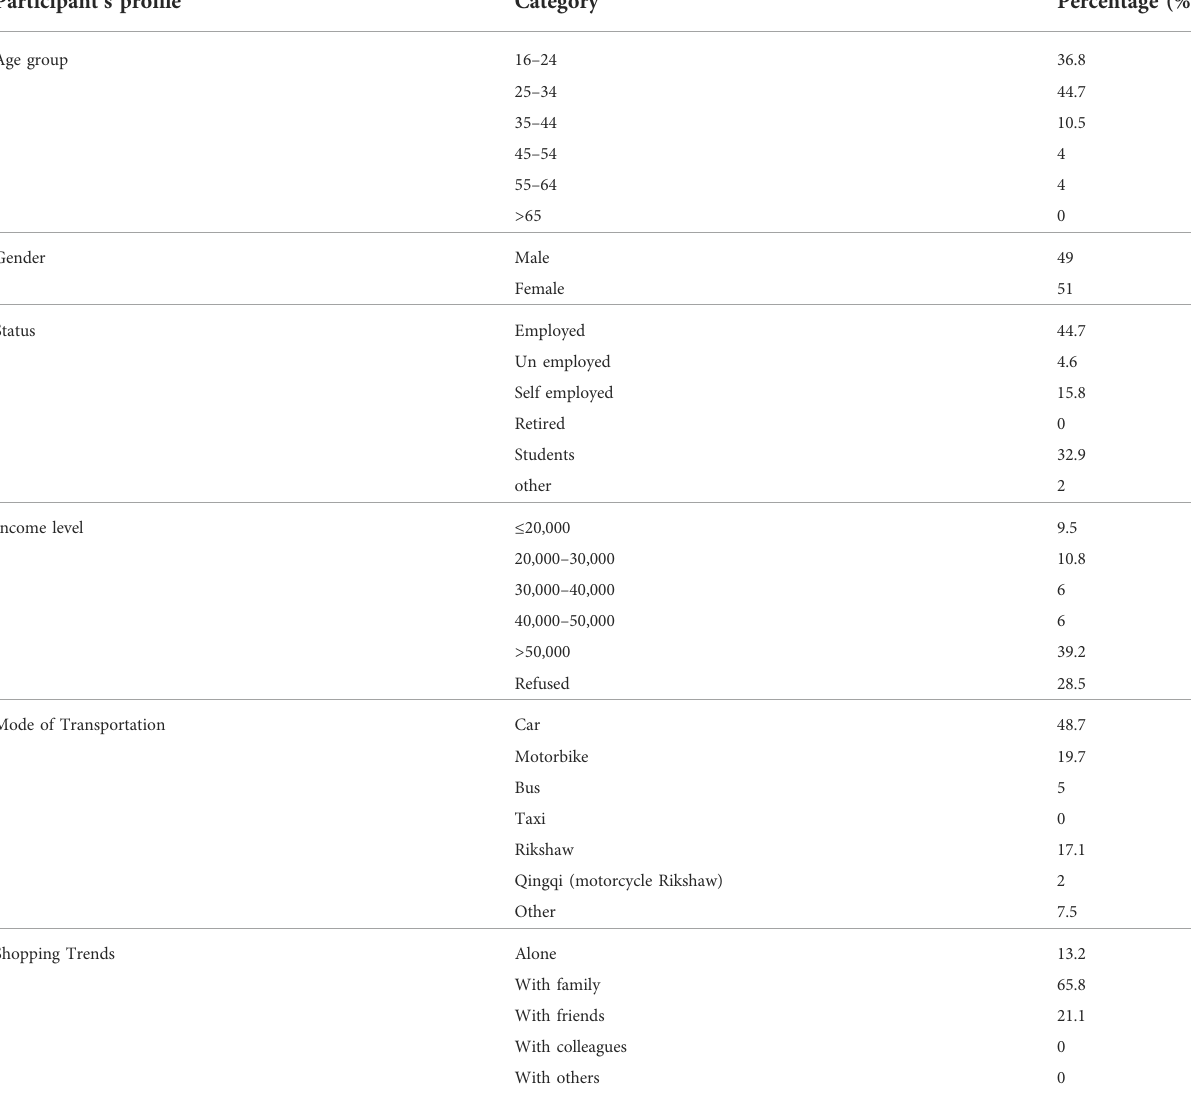
TABLE 1 Descriptive analysis for users ’ pro fi le and perceptions about shopping center vs. traditional bazaar.